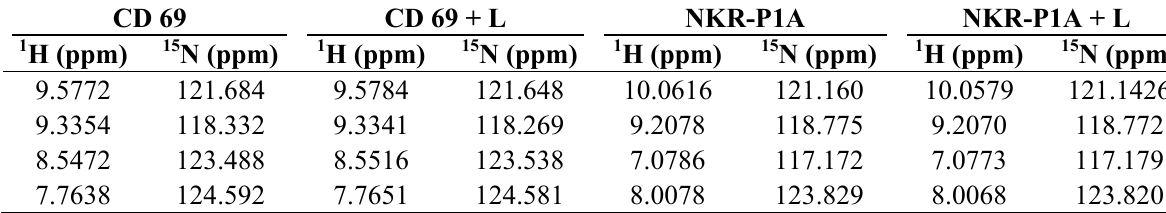
Table 1. Chemical shift differences of four representative pairs of corresponding cross-peaks (from different spectral regions), demonstrating that the chemical shift changes caused by the addition of the ligand (L = p NP-GlcNAc) were negligible. Differences on the order of 10 − 3 ppm cannot be ascribed to the ligand binding and result from experimental